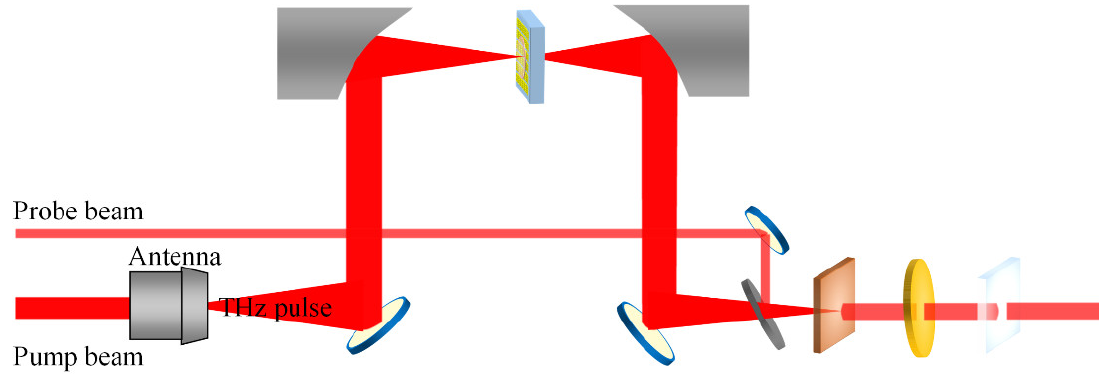
Figure 9. The working principle of THz-TDS.